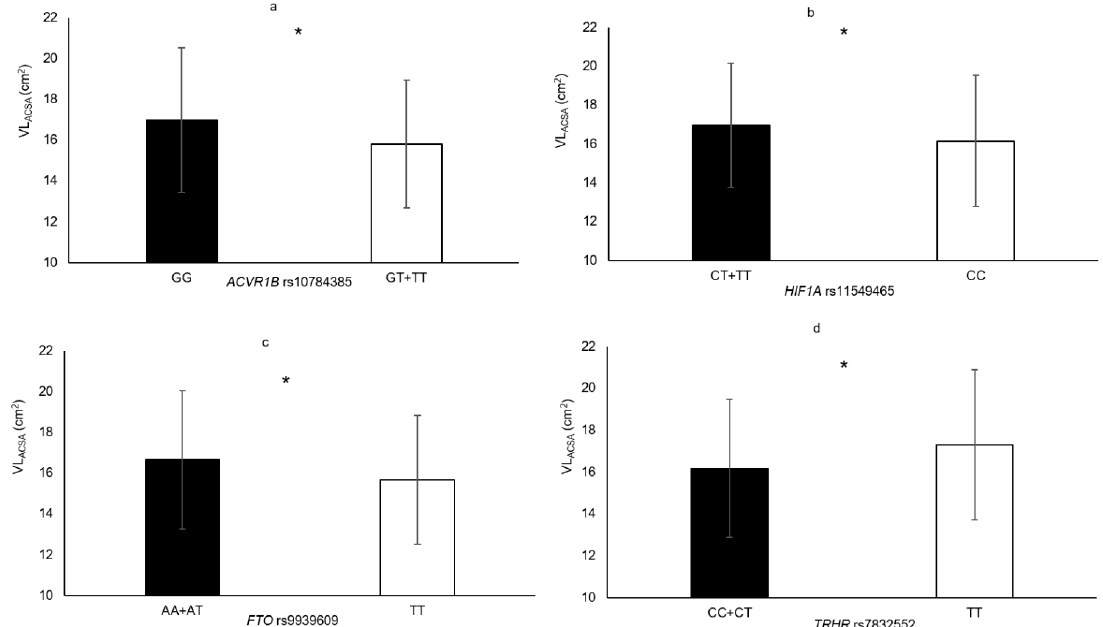
Figure 4. Biceps brachii thickness in genotype groups for ( a ) ACVR1B rs10784385 (GG = 124 vs. GT + TT = 166, ∆ = 4.6%); ( b ) MSTN rs1805086 (CT = 9 vs. TT = 282, ∆ = 14.7%). * denotes significant difference. Data are mean ± SD.